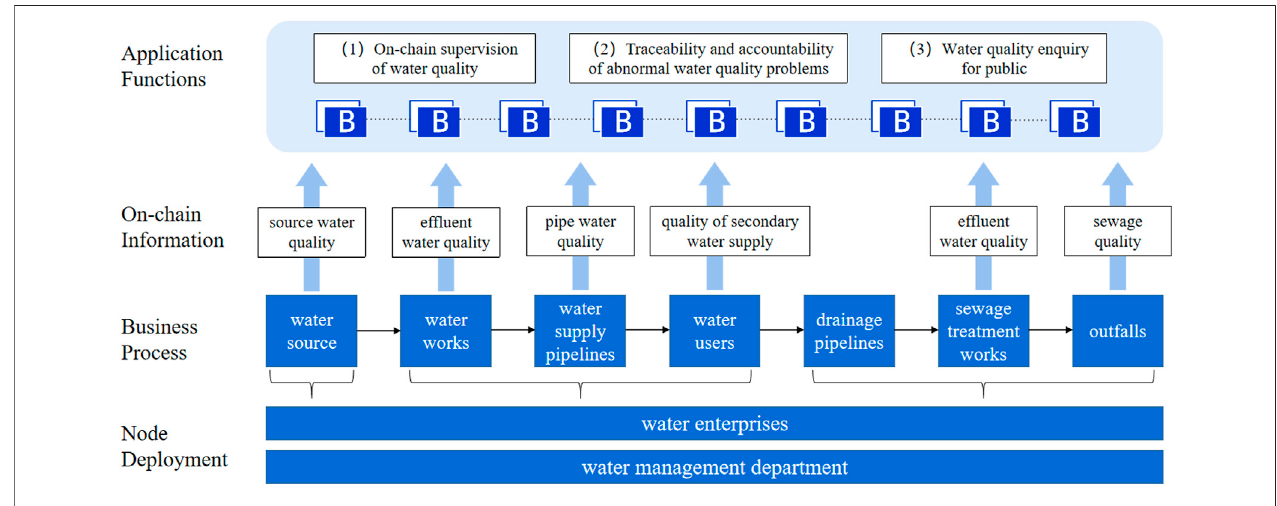
FIGURE 5 | The application scenario of reliable water quality traceability